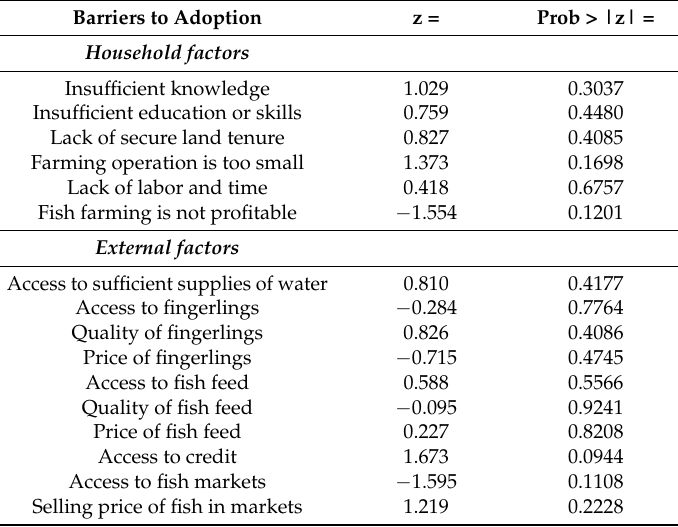
Table 7. Statistical test of differences about barriers to adoption of improved fish farming practices or technologies between poor and non-poor households ( n = 340).